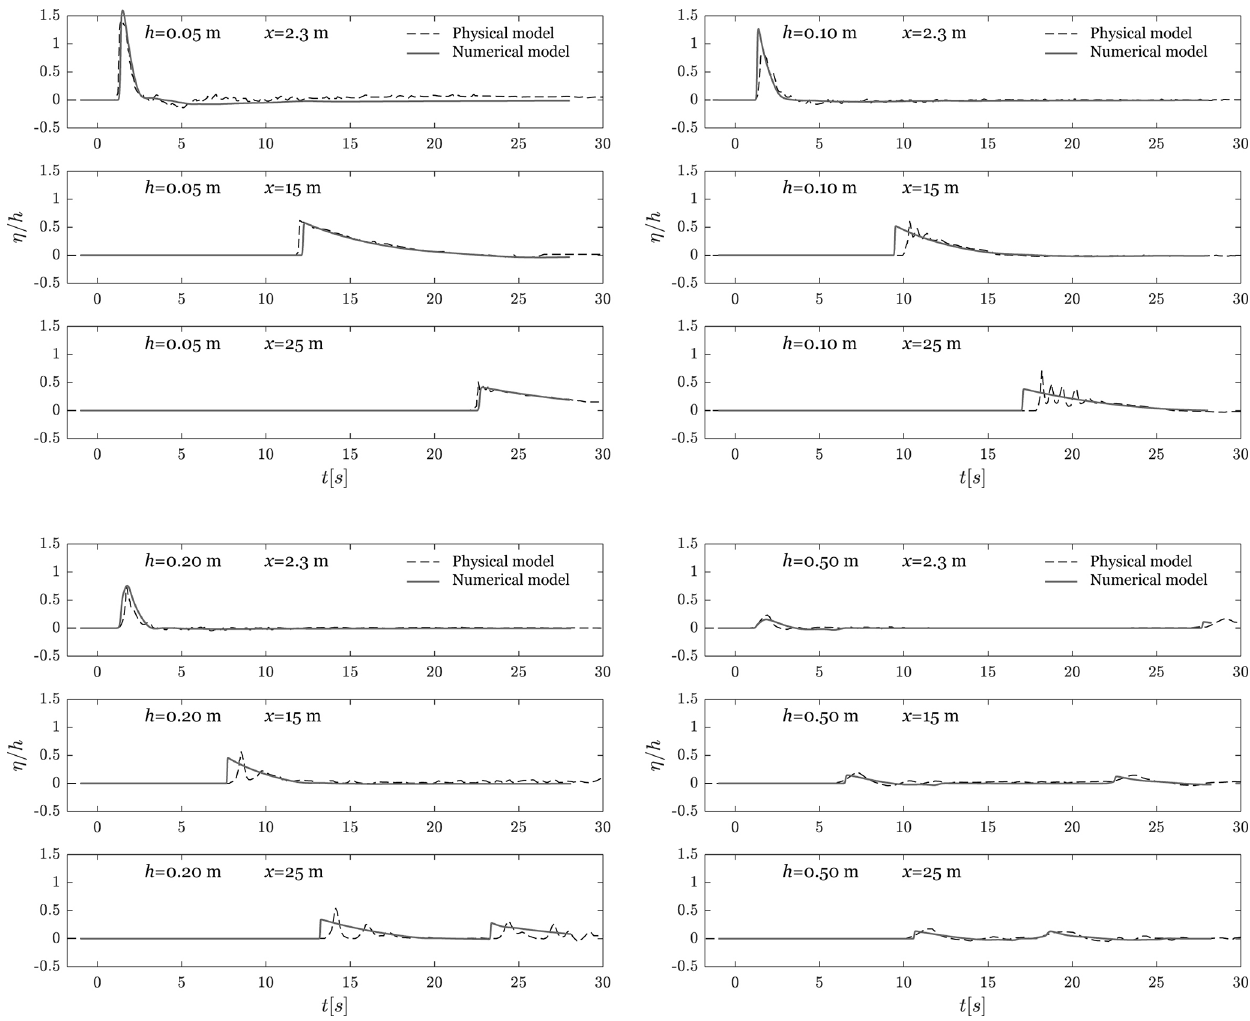
Figure 9. Time series of the relative water surface elevation η/h for different still-water depths h (0.05, 0.10, 0.20 and 0.50m) observed at different wave probes or gauges (2.3, 15 and 25m) (modified from Miller et al.,